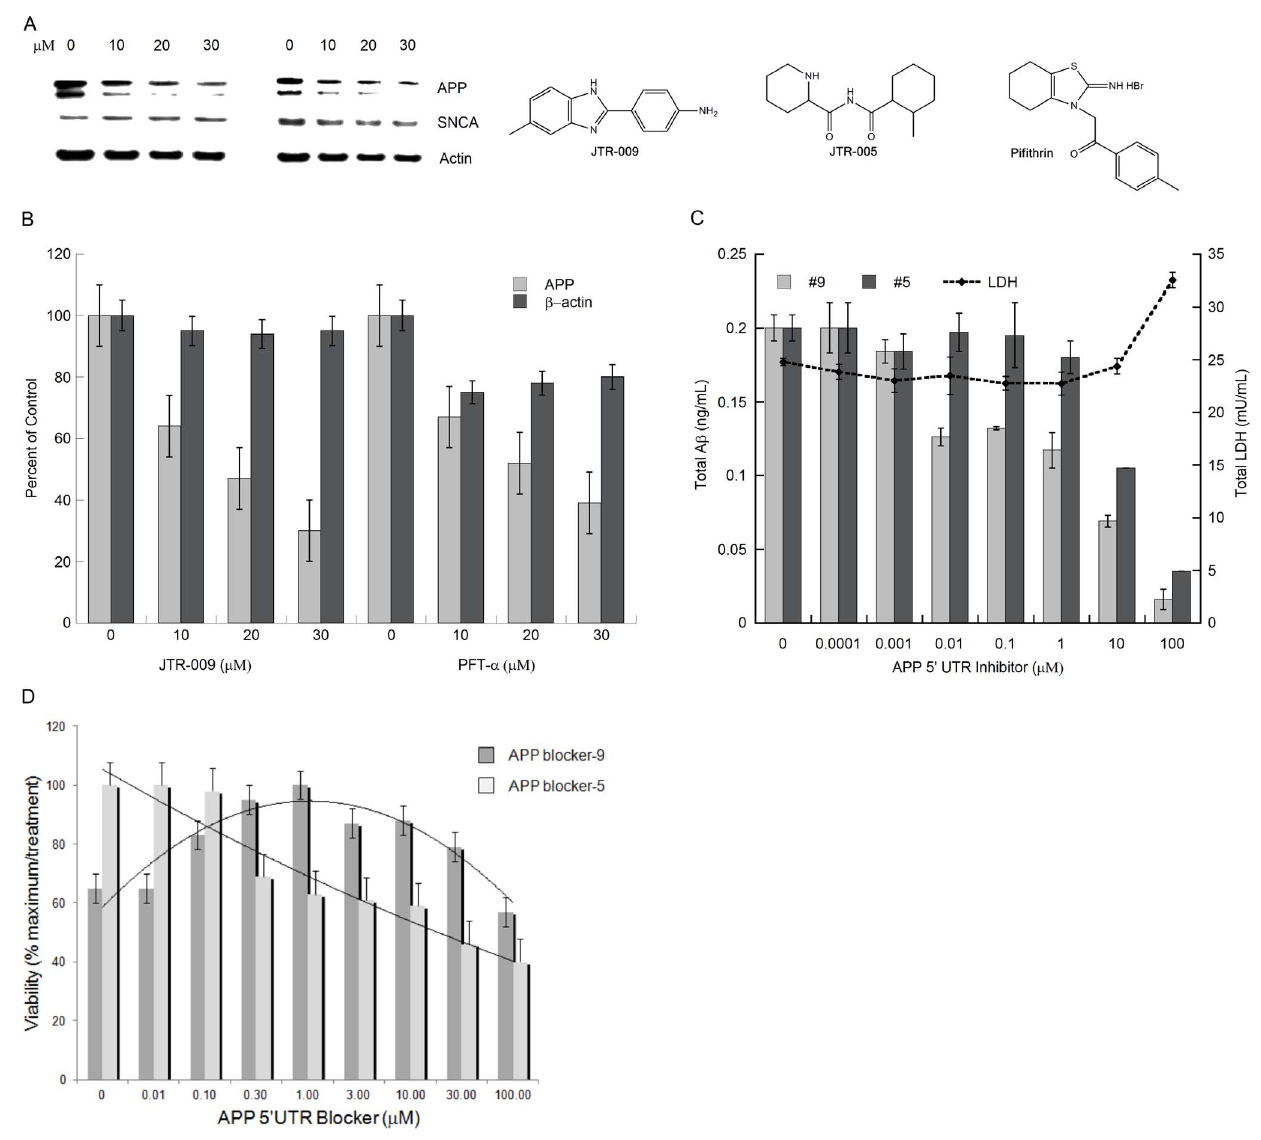
Figure 3. The effect of JTR-009 to reduce the steady state levels of APP in SH-SY5Y cells with a high degree of selectivity in the absence of changes to the levels of b -actin and a -synuclein ( SNCA ). Panels A and B : Dose-responsive (0, 10 m M, 20 m M, 30 m M) treatment of SH-SY5Y cells for 48 h to measure the capacity of JTR-009 and PFT- a to limit APP expression relative to b -actin and SNCA levels. The representative western blot experiment in Panel A contributed to densitometry for the histogram shown in Panel B (N=3). Right Panel: Chemical structure of JTR- 009, 4-(5-methyl-1H-benzimidazol-2yl) aniline, compared to the anti-apoptotic stroke agent PFT a , (275 Da), a tricyclic benzothiazole. Panel C : Dose- responsive measurement of total amyloid A b levels in response to the APP 5 9 UTR inhibitors JTR-005 and JTR-009, measured by benchmarked ELISA in conditioned medium of 72-hour treated SH-SY5Y cells. Shown are the mean values for the reduction of levels of A b 6 SEM (N=4) after treatment of the cells with JTR-009 and JTR-005 at 0.01 m M (*=p , 0.01), 0.1 m M (**=p , 0.015), and 1 m M (***=p , 0.01) analyzed by ANOVA (N=5). Dotted line: Representative LDH assay parallel to A b determination for SH-SY5Y cells treated for 72 h at concentrations up to 100 m M of JTR-009 (N=4). Panel D : MTS assay for cellular mitochondrial viability after treatment of SH-SY5Y cells with JTR-005 and JTR-009 at the concentrations shown. Y axis: Percent of maximal viability 6 SEM after treatment of the cells with JTR-009 and JTR-005 (N=3)). Shown are the relative trend-lines for the dose-responsive viability of JTR-005 and JTR-009 compared to untreated cells (‘poly’=non linear polynomial regression of the